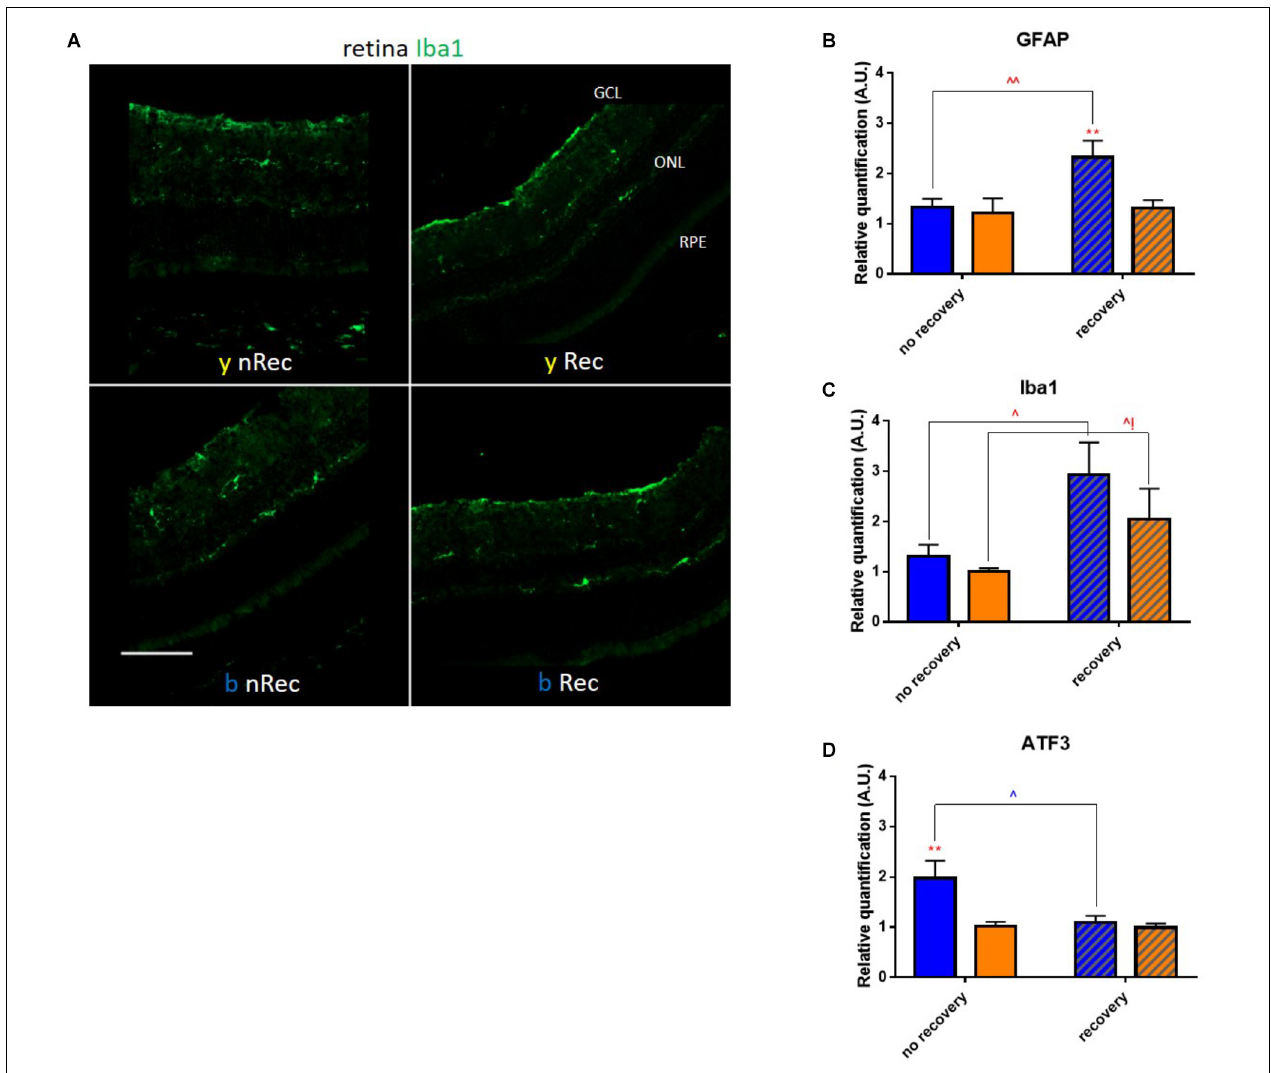
FIGURE 5 | Light-induced retinal inflammation (2). (A) Immunohistochemistry was performed on the retinas of blue- ( b ) and yellow-exposed ( y ) mice either immediately after illumination ( nRec ) or in 3 days of recovery ( Rec ). Results of anti-Iba1 staining is presented. Magnification is 20x, scale bar corresponds to 100 µ m. (B–D) Results of RT-qPCR analysis on the retinas: mRNA expression of GFAP (B), ATF3 (C) and Iba1 (D). Statistical significance: - GFAP: blue no recovery vs. recovery – q = 0.0101, p = 0.0096; recovery blue vs. yellow – q = 0.0074, p = 0.0070; - ATF3: blue no recovery vs. recovery – q = 0.0230, p = 0.0219; no recovery blue vs. yellow – q = 0.0057, p = 0.0054; - Iba1: blue no recovery vs. recovery – q = 0.0118, p = 0.0113; yellow no recovery vs. recovery – q = 0.0428, p = 0.0814. Blue and yellow bars correspond to blue and yellow exposures, respectively; clear and hatched bars correspond to the time points of mice dissection, either directly after illumination ( no recovery ) or in 3 days of recovery ( recovery ), respectively. All the data are presented as mean ± SEM. Differences were considered significant when p < 0.05 ( ∗ / ∧ ), p < 0.01 ( ∗∗ / ∧∧ ), p < 0.001 ( ∗∗∗ / ∧∧∧ ) or p < 0.0001 ( ∗∗∗∗ / ∧∧∧∧ ). Stars correspond to comparisons between blue-illuminated and yellow-illuminated mice, within one recovery or non-recovery group. Carets correspond to comparison of mice assessed directly after illumination to the ones assessed after 3 days of recovery, within the same spectra. Red color means increase and blue color decrease in values.